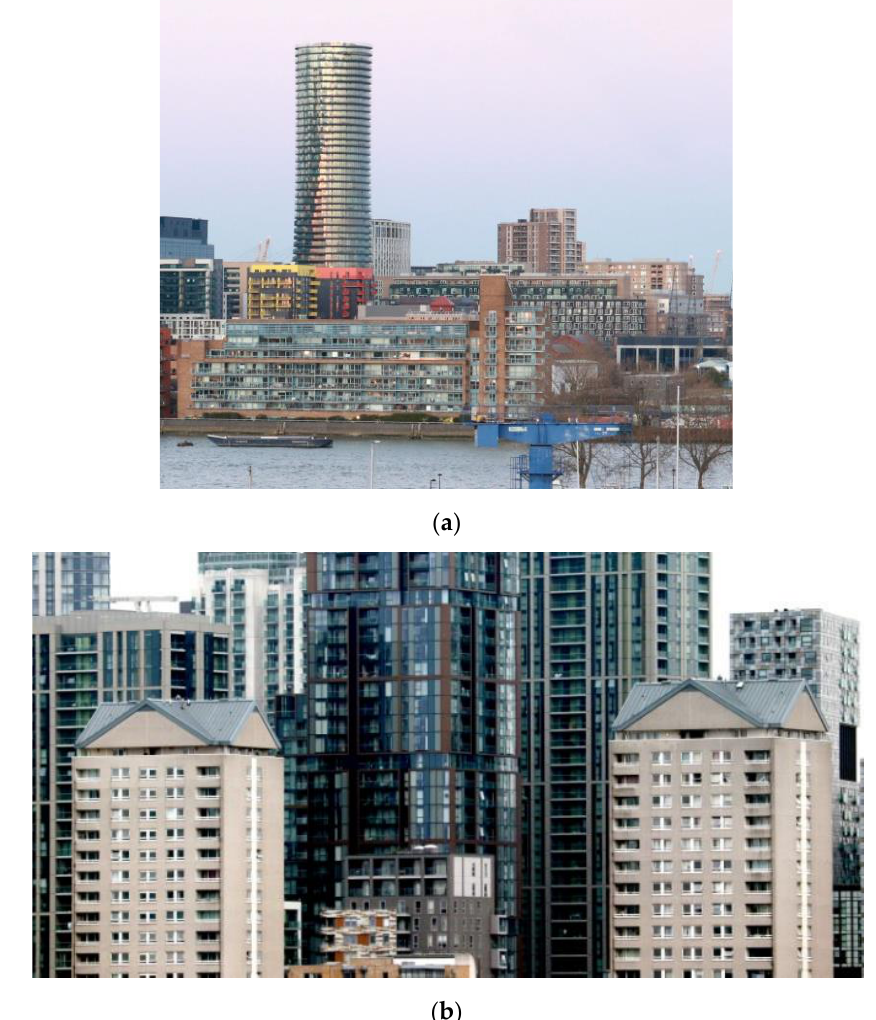
Figure 20. Fluorescent, high saturation colours are visible in any weather conditions and at any distance. ( a ) View of Clover Courts (not included in the study) from the southern bank of the River Thames (2021); ( b ) Monochromatic panorama of tall buildings cluster in the Isle of Dogs on a cloudy day (2021).